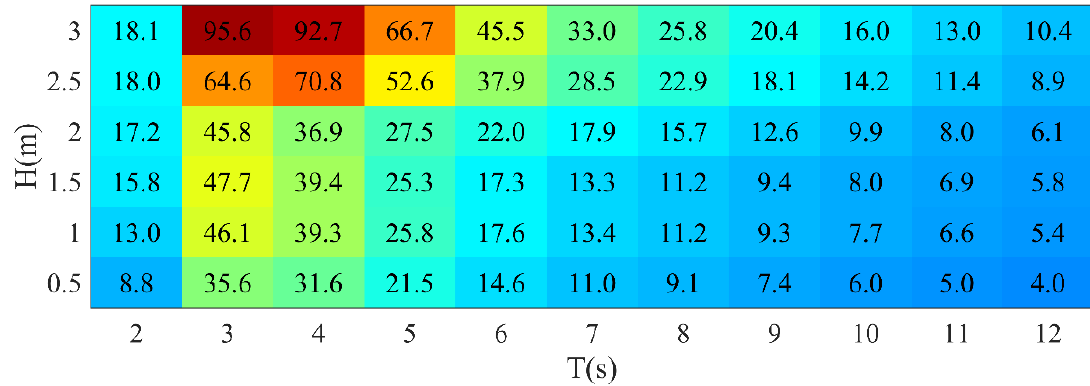
Figure 8. NS-PWEC power generation efficiency under regular wave sea conditions.